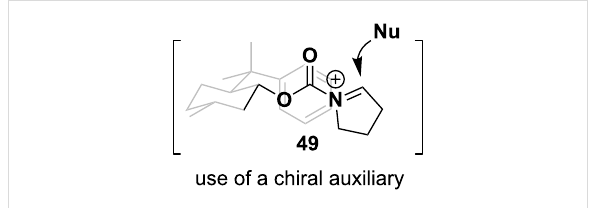
Figure 5: Example of a chiral auxiliary Shono-oxidation intermediate